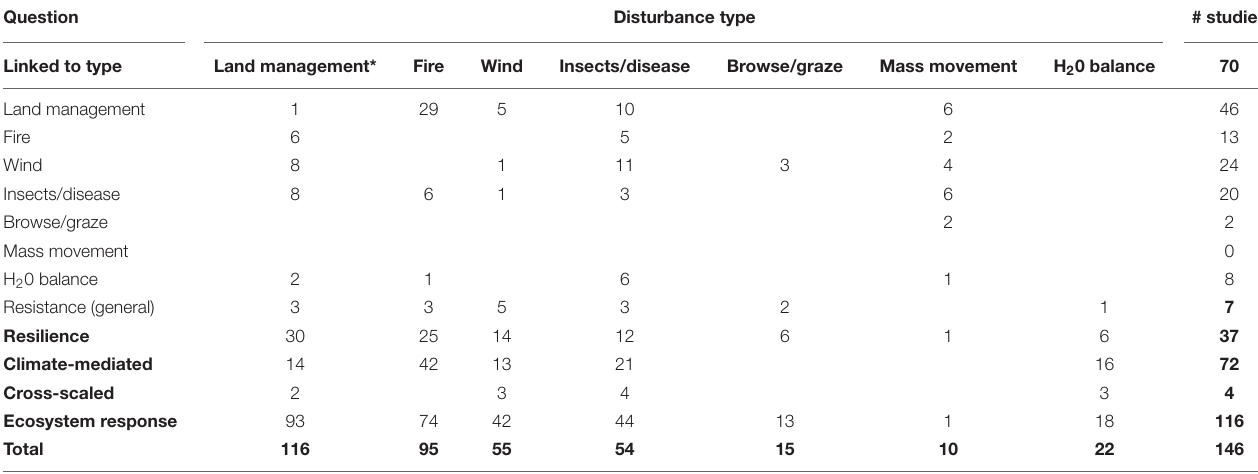
TABLE 5 | Frequency of explicit disturbance interaction questions addressed by studies in the systematic review ( Supplementary Materials